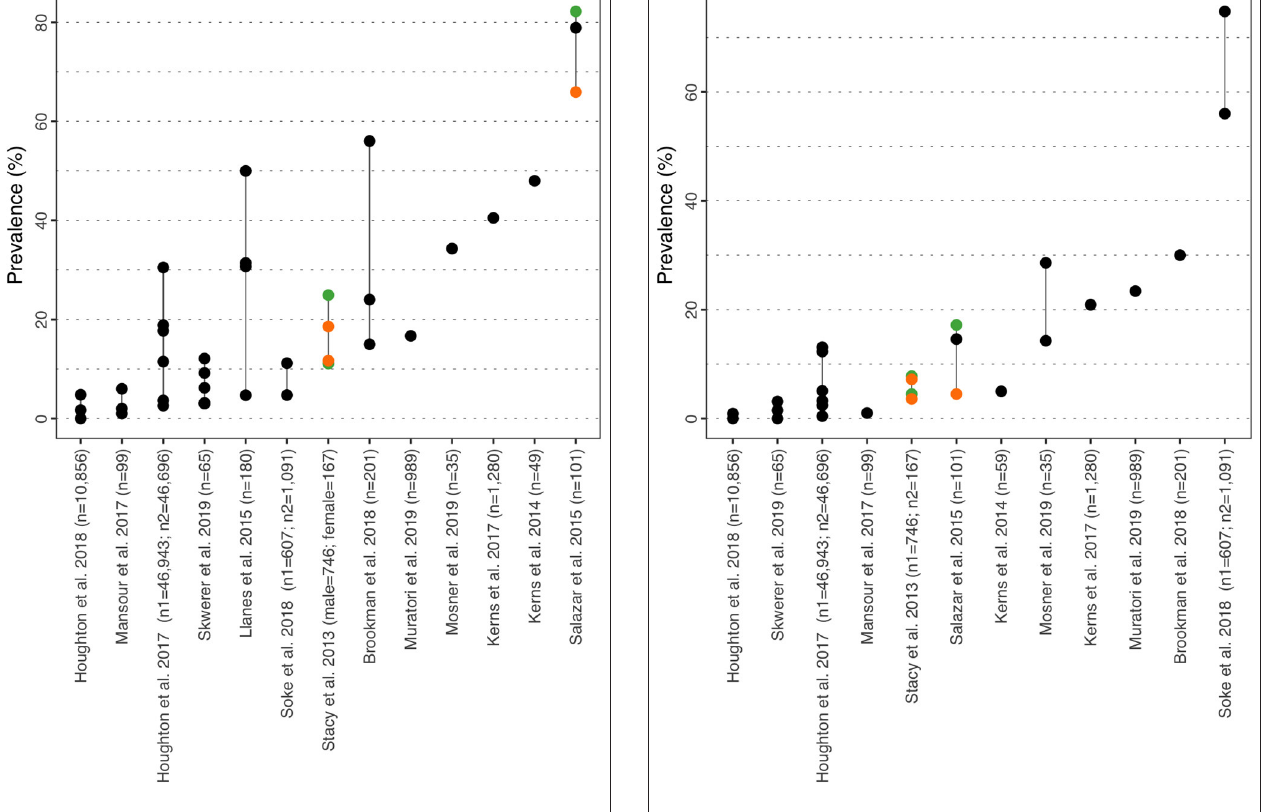
FIGURE 4 | Anxiety prevalence estimates. Each point reports a prevalence estimate for the related comorbidity. Studies with more than one data point indicate the estimate of the prevalence among different subgroup of the population. See Supplementary Table 4 for the description of the population used in each study. Sample sizes are shown in brackets above each study label. Orange mark: Female population only; Green mark: Male population only; Black mark: No sex distinction.